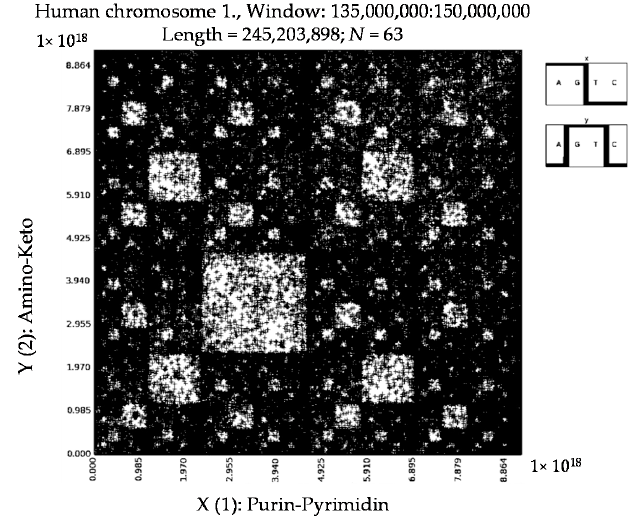
Figure 11. Examples of binary mosaics for two parts of Homo sapiens chromosome 1 [41,42], which has 245,203,898 nucleotides: one part corresponds to interval of this sequence from 45,000,000 to 60,000,000 nucleotides, and the second part corresponds to the interval from 135,000,000 to 150,000,000 nucleotides.